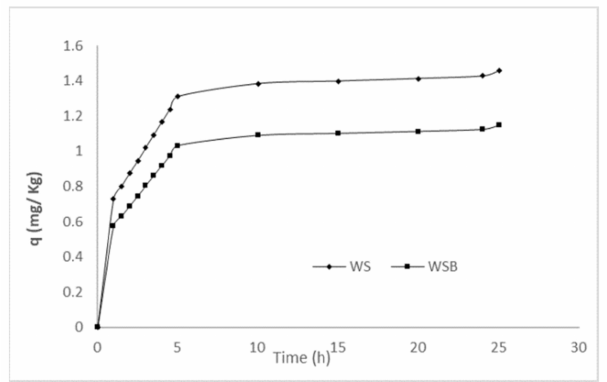
Figure 5. Adsorption capacity of WS and WSB in batch